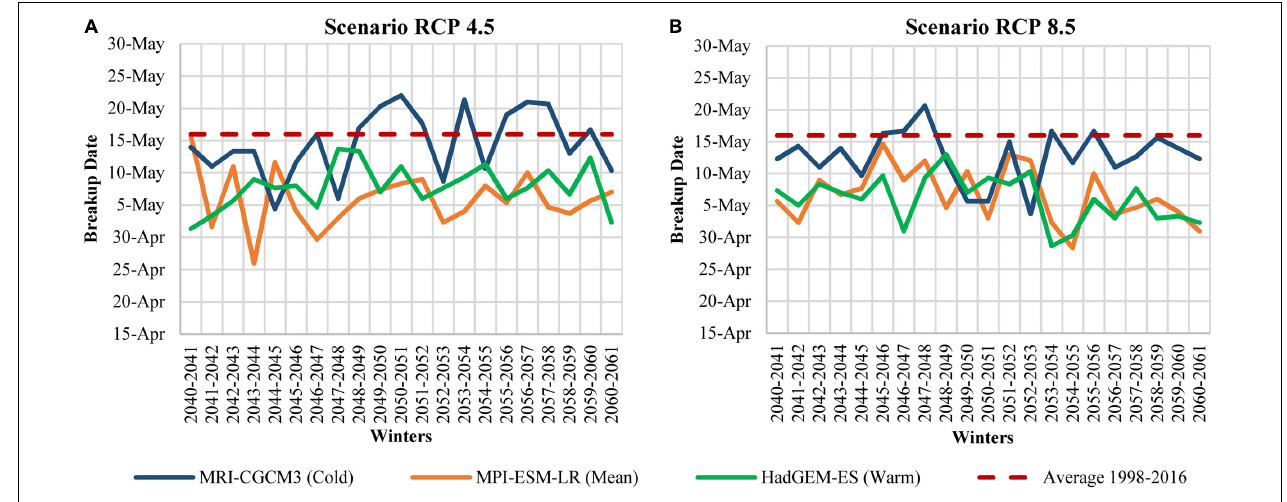
FIGURE 13 | Comparison of breakup dates in James Bay for the 2040–2060 period under climatic scenario RCP4.5 (A) and RCP8.5 (B)